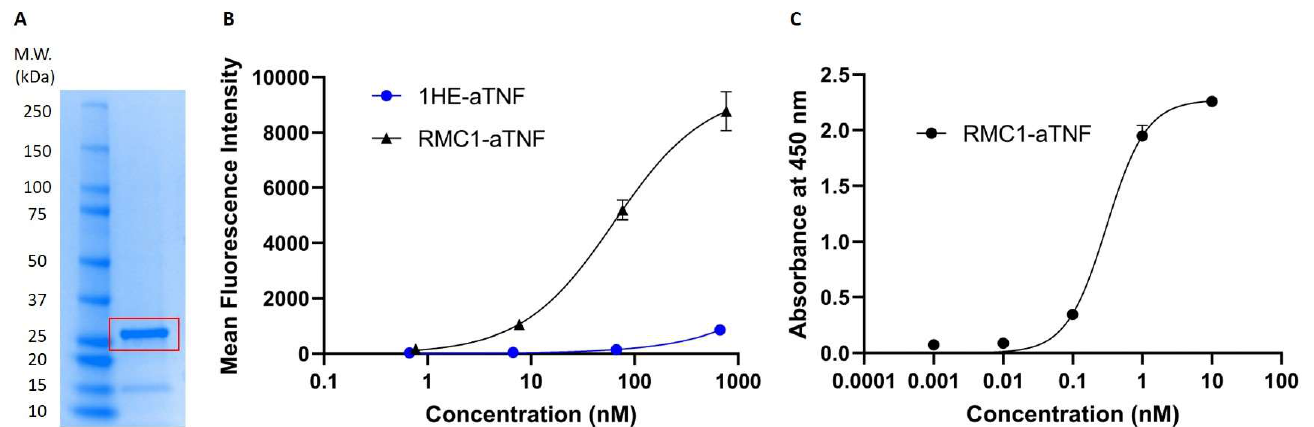
Figure 4. Assessment of binding activity of anti-RBC fusion constructs: ( A ) SDS-PAGE analysis of the anti-RBC-TNF- α RMC1-aTNF bispecific antibody. ( B ) Binding assessment via flow cytometric analysis of purified bispecific sdAb fusion RMC1-aTNF to mouse red blood cells. The anti-RBC-TNF α bispecific sdAb fusion protein was able to retain the RBC binding affinity of RMC1, with an estimated K D of 63.9 nM. The control bispecific sdAbs 1HE-aTNF has some degree of nonspecific binding at the very high concentration of 1 µ M. ( C ) Binding assessment via direct ELISA of purified bispecific sdAb fusion RMC1-aTNF to human TNF α . The sdAb aTNF was originally reported to have a high binding affinity to human TNF α with KD around 130 pM [13]. The anti-RBC-TNF α bispecific sdAb fusion protein was able to retain most of this binding affinity, with an estimated KD of 307 pM.